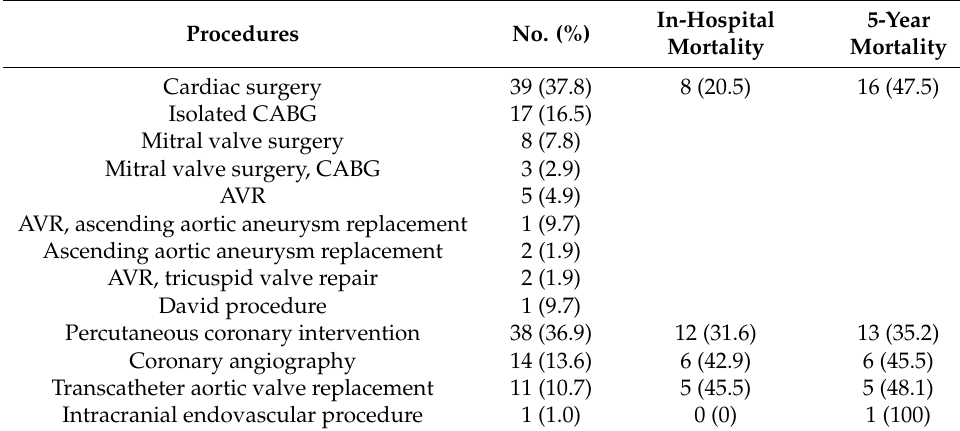
Table 3. Cardiovascular procedures resulting in iatrogenic acute TAAD and their related in-hospital and 5-year mortality